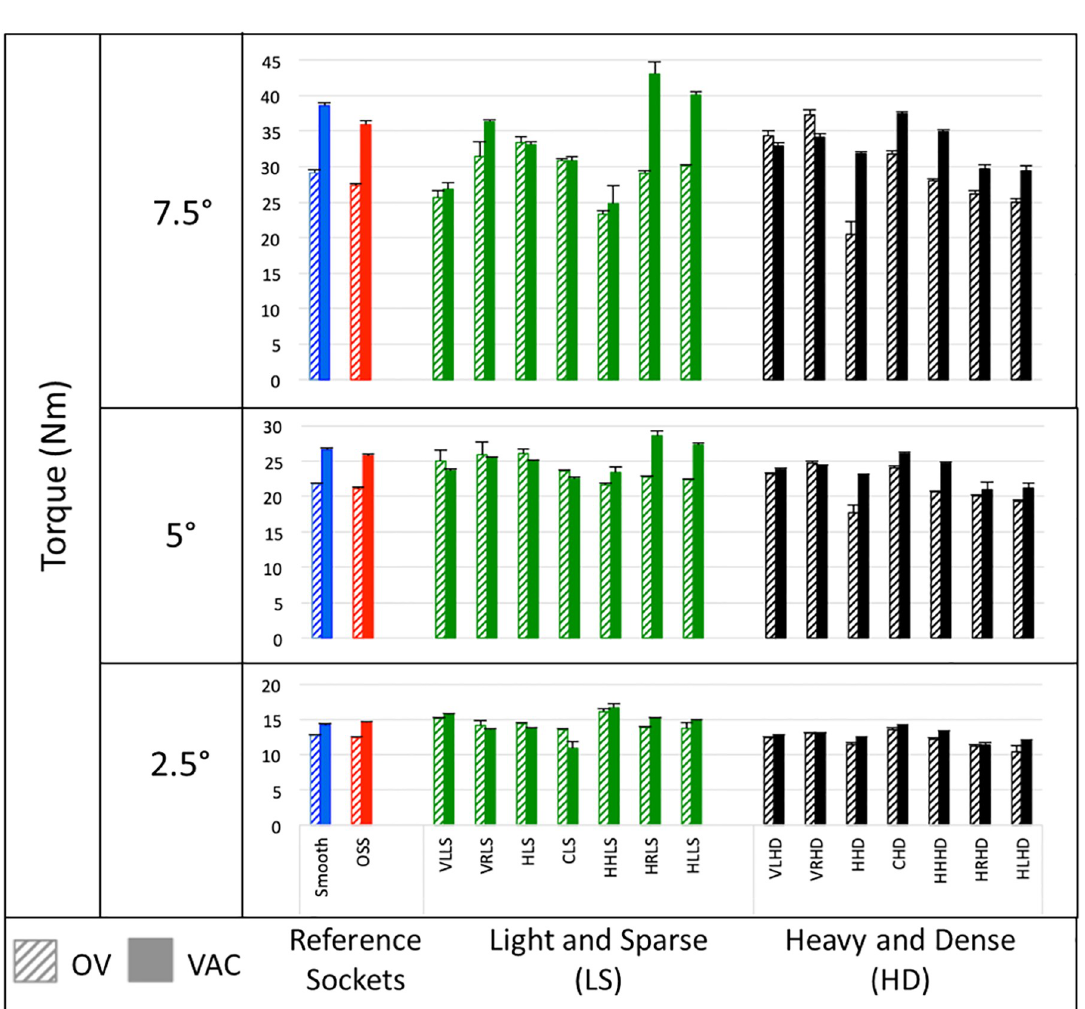
Fig 7. Mean torques in the transverse plane for passive suction suspension with one-way valve (OV) and active vacuum with pump at 20 inHg (67.73 kPa) (VAC). Textures are organized from left to right from those with a primarily vertical orientation of texture pattern to those with a primarily horizontal orientation of texture pattern. Also, heavy and dense (HD) patterns are grouped to the right of light and sparse (LS)